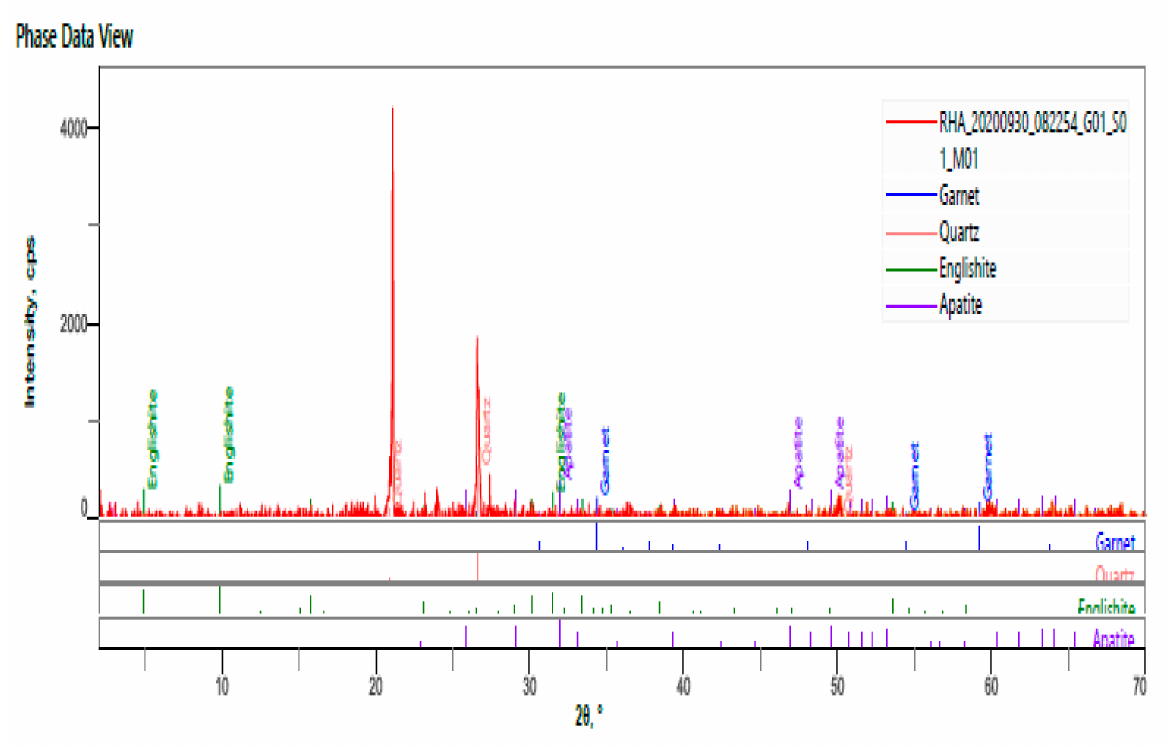
Figure 3. The XRD patterns